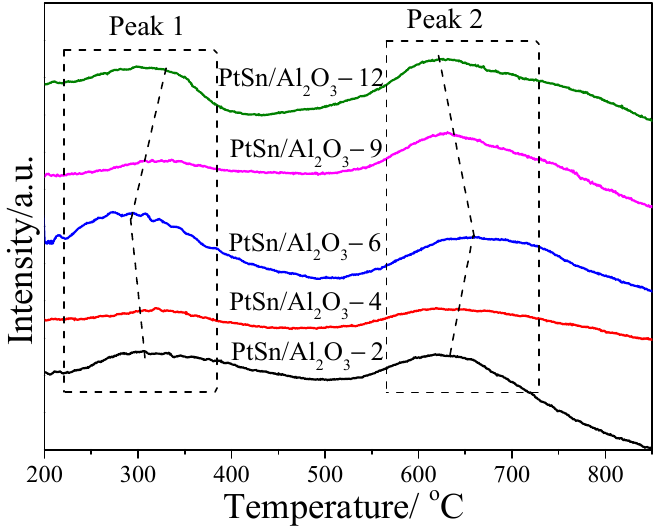
Figure 5. NH 3 -TPD profiles of PtSn/Al 2 O 3 catalysts.